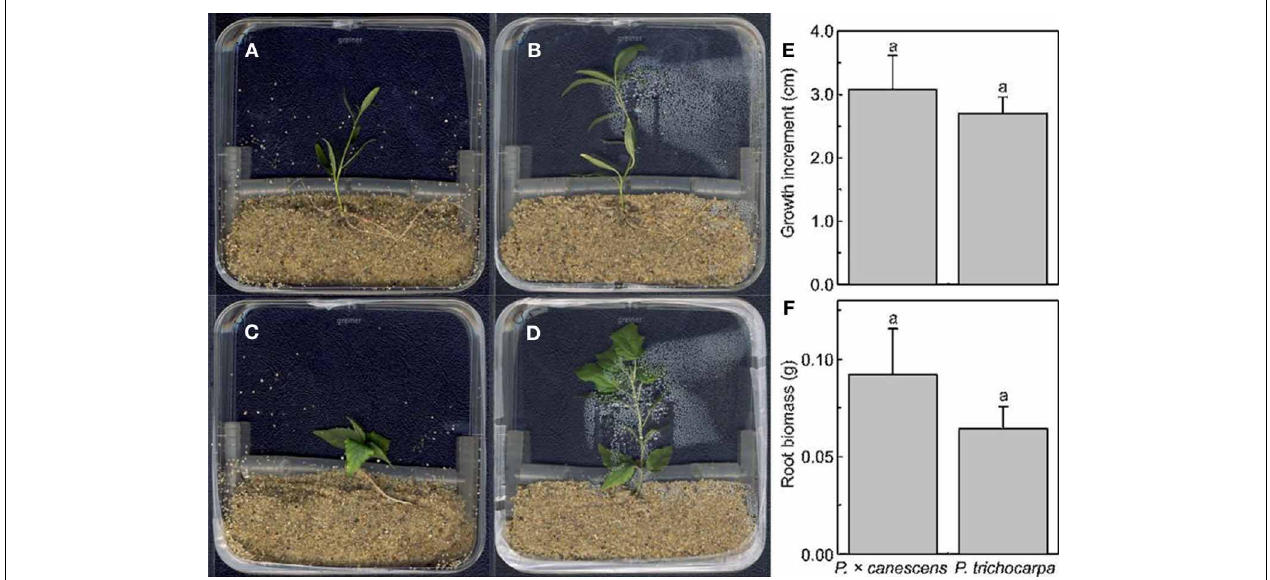
FIGURE 2 | Poplar plantlets in a Petri dish system under axenic conditions in sand. Petri dishes with P. trichocarpa immediately after planting (A) and after 5 weeks (B) . Petri dishes with P . × canescens immediately after planting (C) and after 5 weeks (D) .